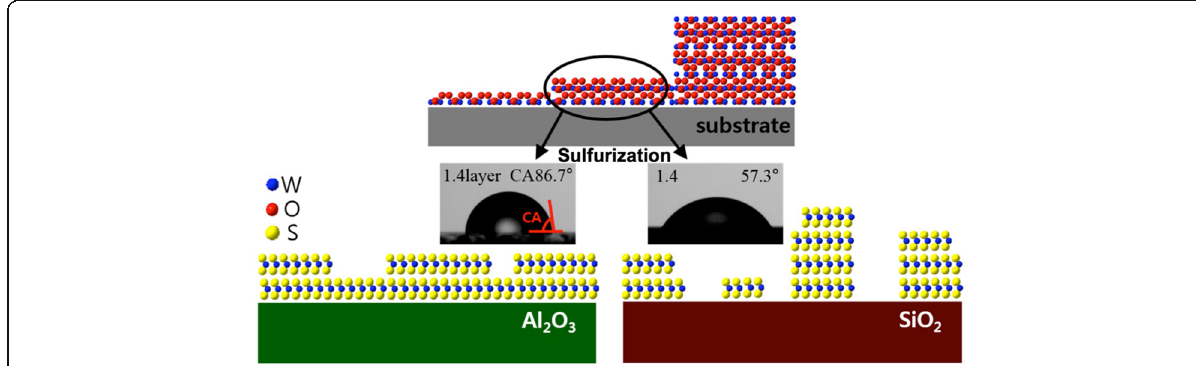
Fig. 1 Schematic diagram of a step-like thickness gradient WO 3 film and the sulfurized WS 2 films on Al 2 O 3 and SiO 2 /Si substrates. Water contact angle (CA) images show different CAs on different substrates for 1.4 monolayer of WS